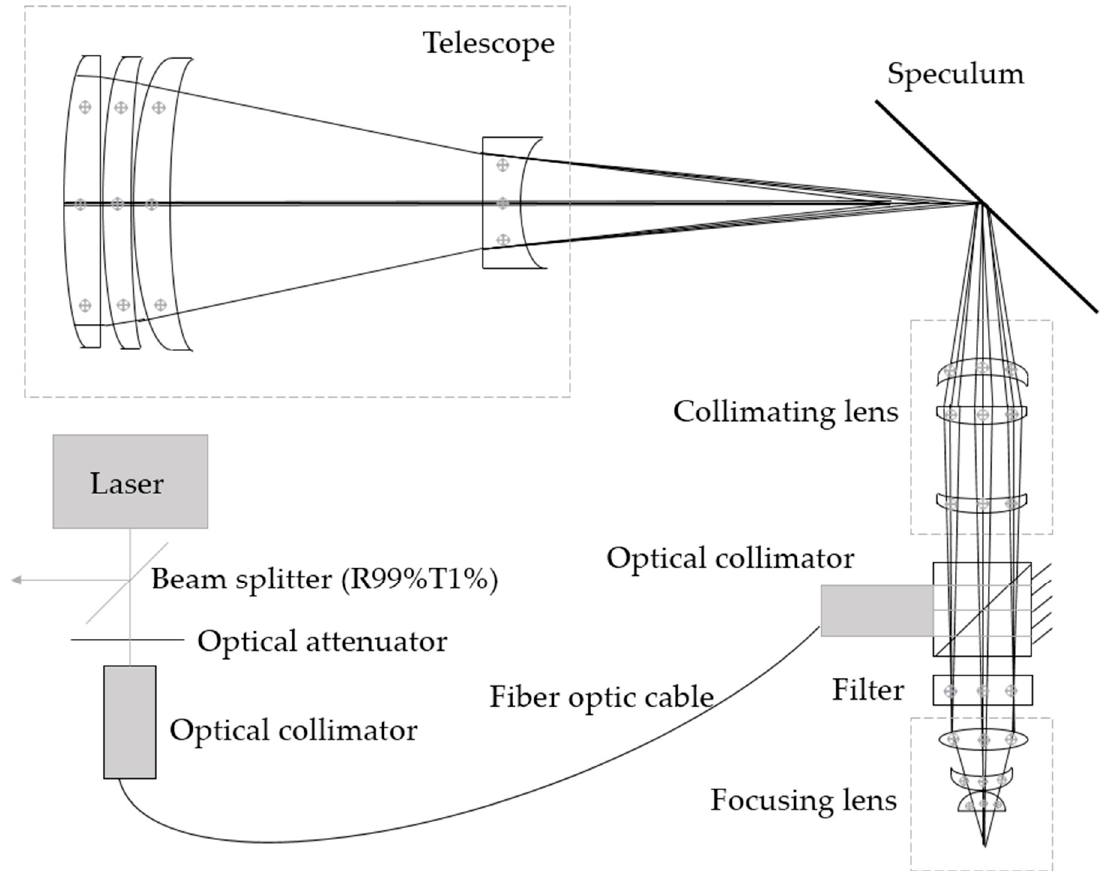
Figure 2. Laser sensor unit design.